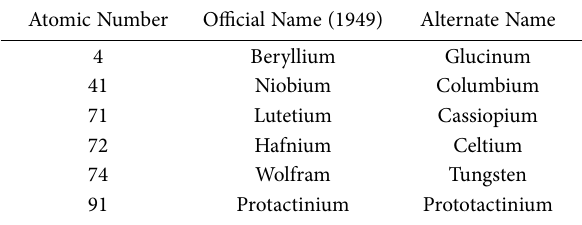
Figure 3. Elements whose names were changed by the CNIC in 1949.